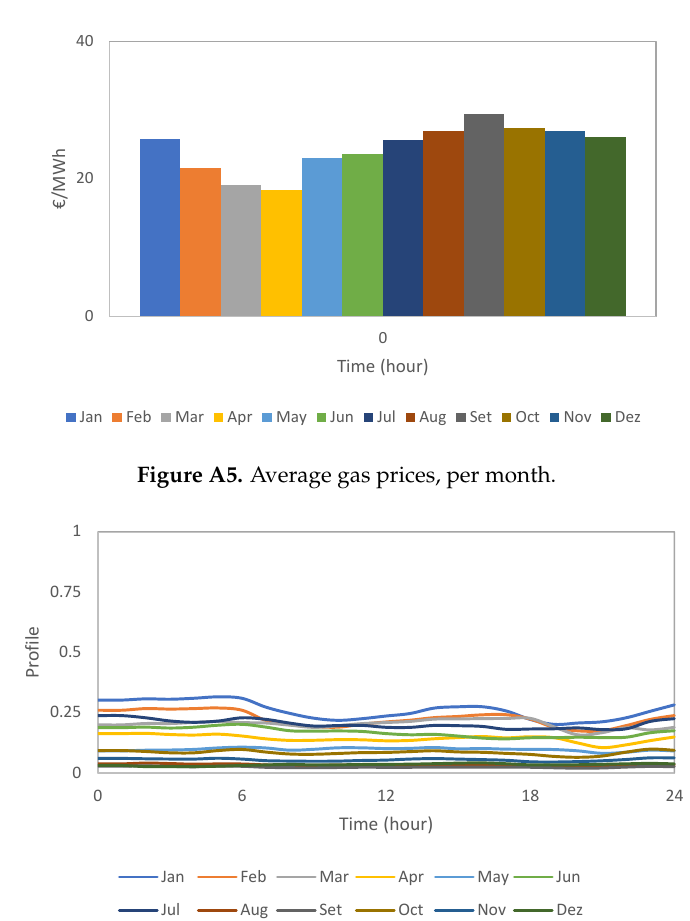
Figure A4. Average daily electricity prices, per month.